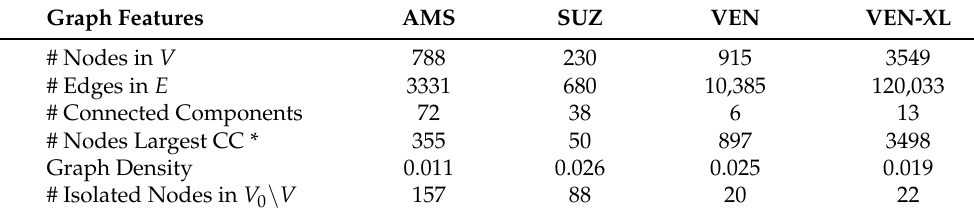
Table 6. The statistics for the back-end Geographical Network G = ( V , E , w ) . “#” means “the number of” in the